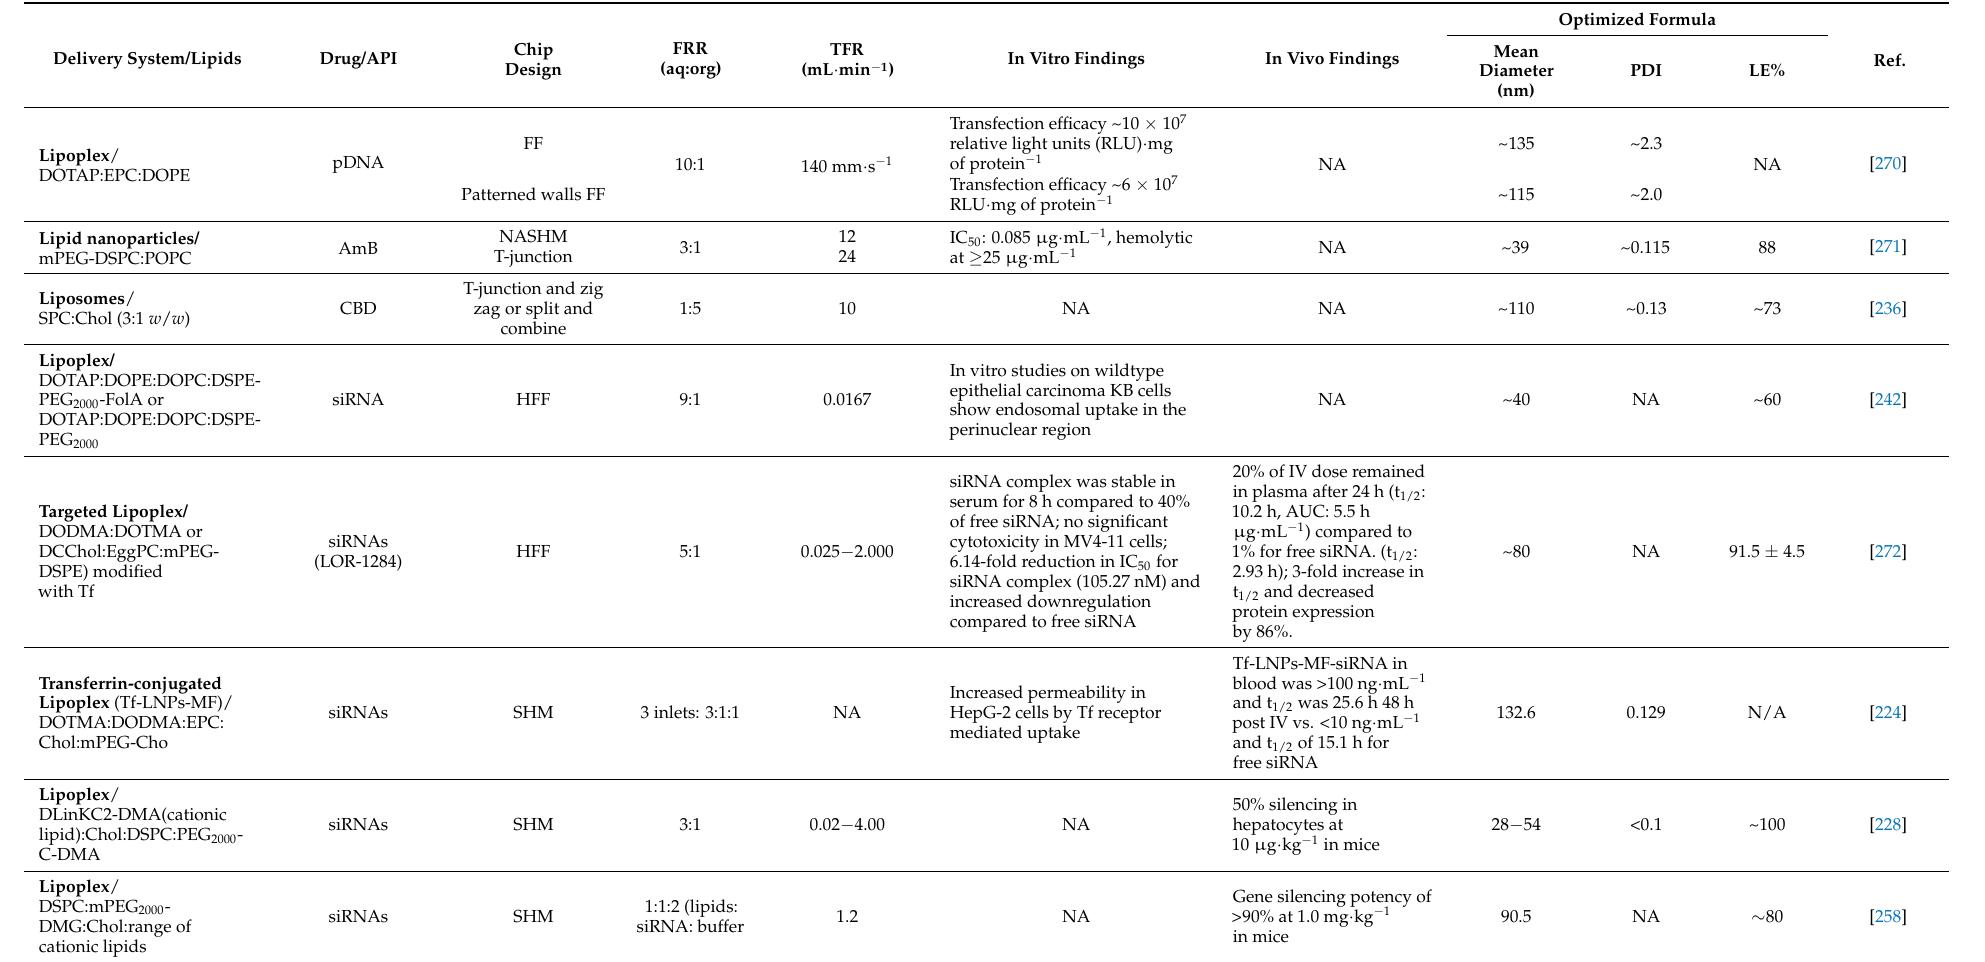
Table 3. Summary of microfluidic manufactured lipid-based